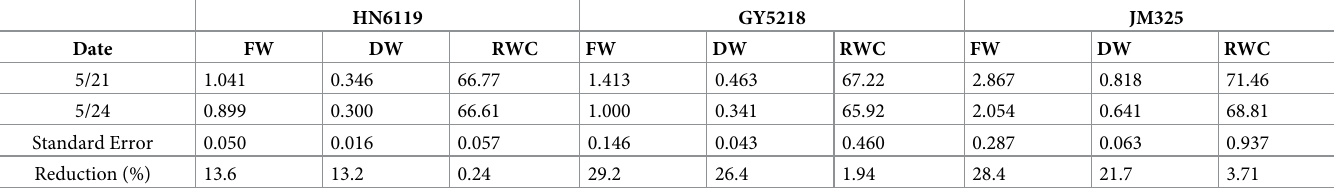
Table 4. FW (unit: g), DW (unit: g), RWC (unit: %) and standard error (unit: g) of the leaves of the three cultivars on the day before and after the DHW day during the 2019